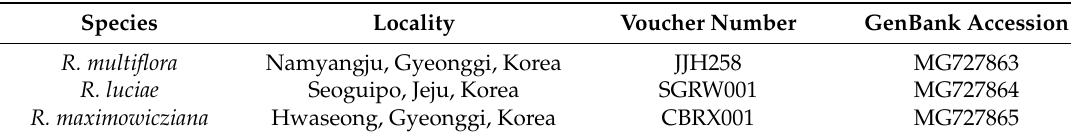
Table 2. Accession information for three Rosa